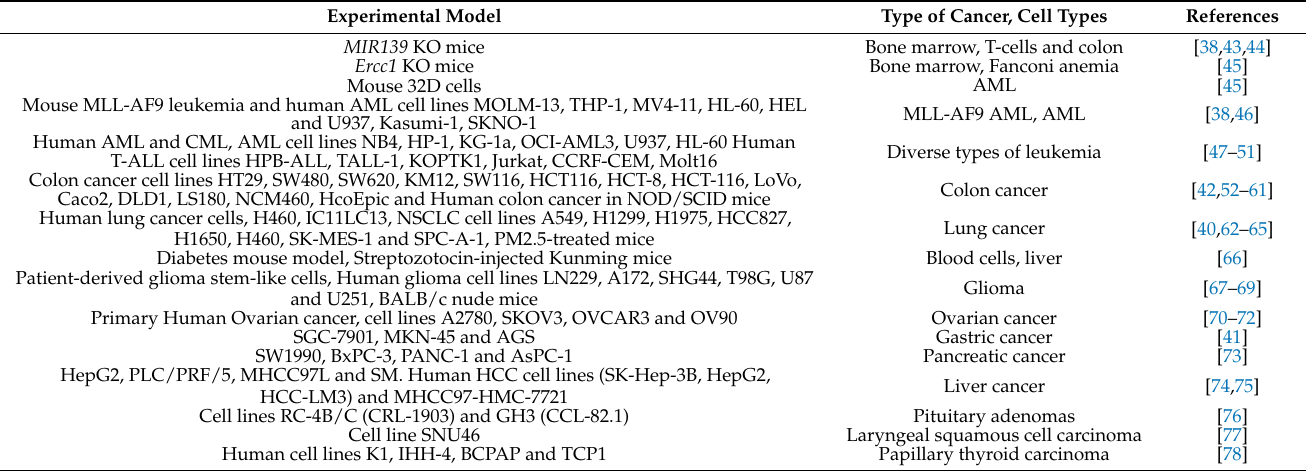
Table 1. Overview of experimental models used for functional MIR139 investigation in the various types of